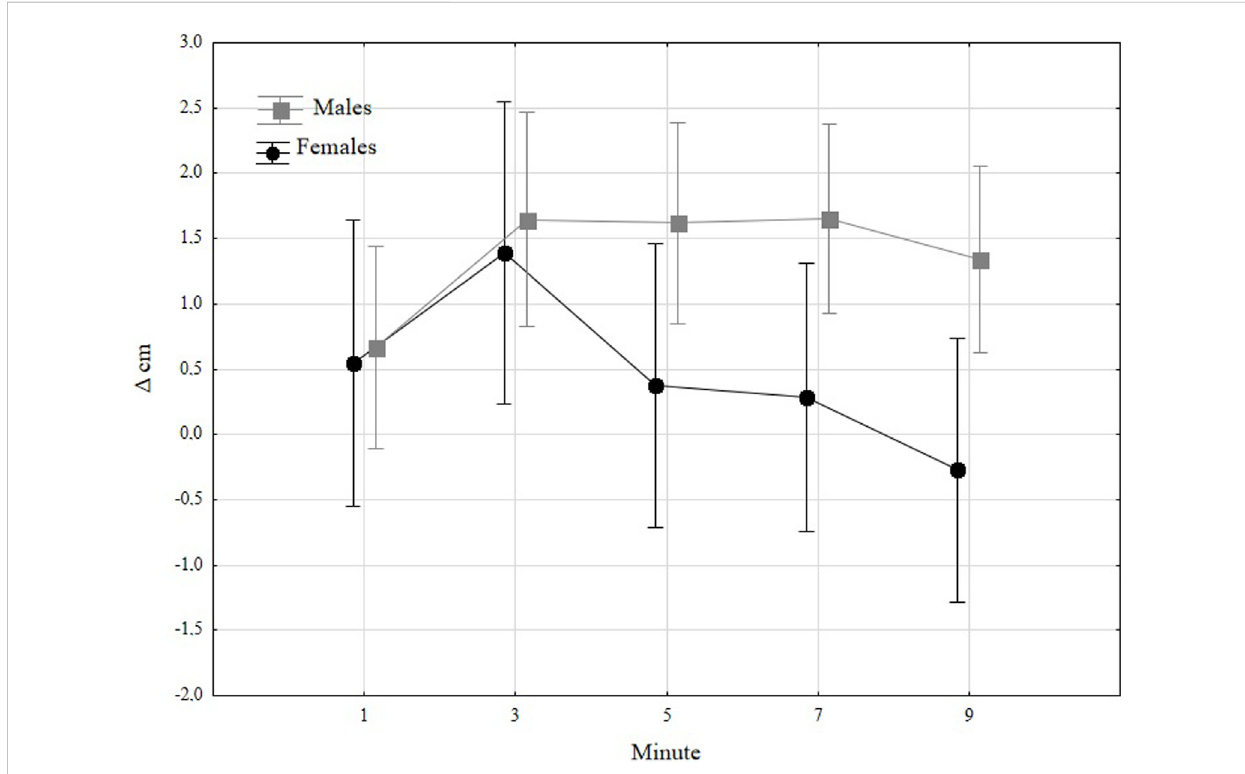
FIGURE 2 Absolute changes ( Δ cm) towards baseline in jump height in males and females.